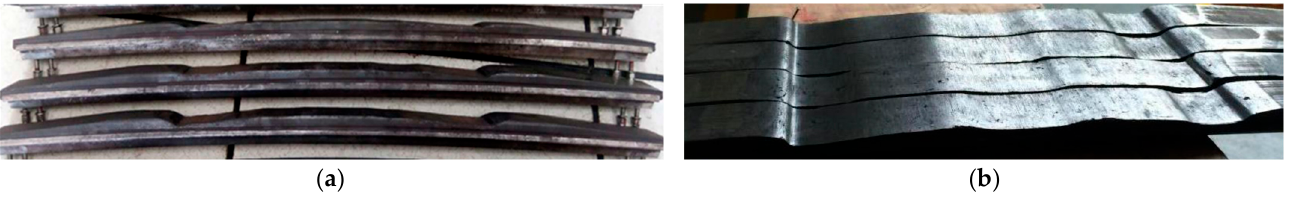
Figure 4. Worn conditions of pantograph strips with irregular wear. ( a ) Pantograph strips with two-groove wear. ( b ) Pantograph strips with three-groove wear.